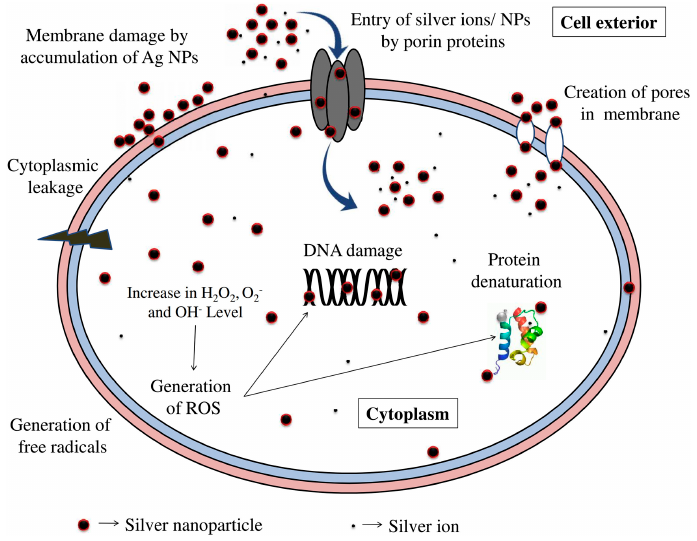
Figure 2. Schematic representation of the known mechanisms of antibacterial action of silver nanoparticles and silver ions. Reprinted from [108], with permission from